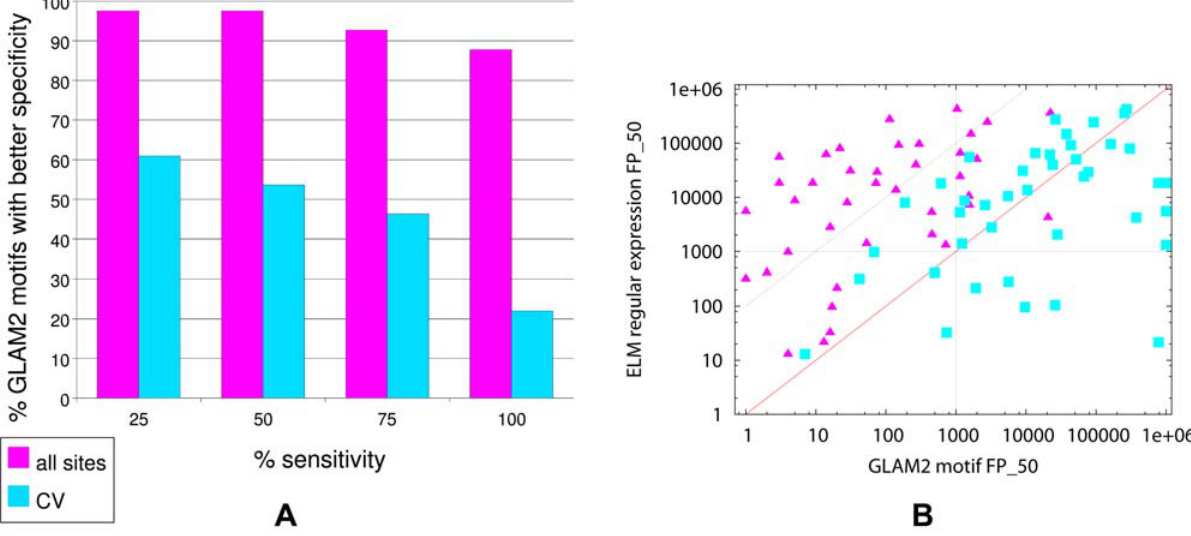
Figure 4. Sensitivity versus specificity trade-off of GLAM 2 motifs. (A) shows how often the GLAM 2 motif has better specificity than the corresponding ELM RE as a function of the sensitivity level. (B) shows the specificity (FP_50) of the ELM RE and the GLAM 2 motif for each of the 41 ELM entries studied here. Each point represents one ELM motif, with x and y giving the the FP_50 of the GLAM 2 motif and of the ELM RE, respectively. Triangles are motifs learned from all sites; squares show cross-validated